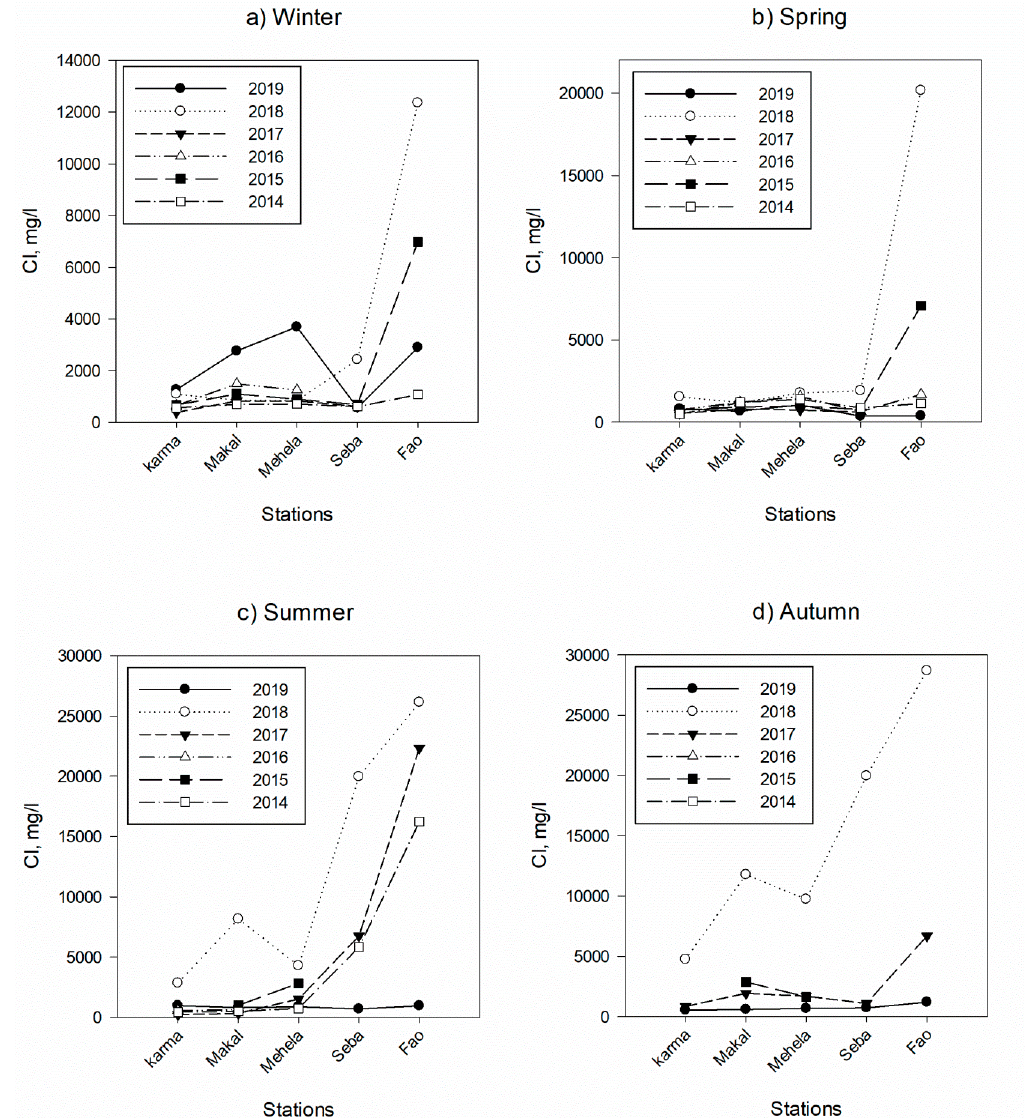
Figure 7. Comparison of Cl concentrations of the selected stations for four seasons during the period of 2014 to 2019.